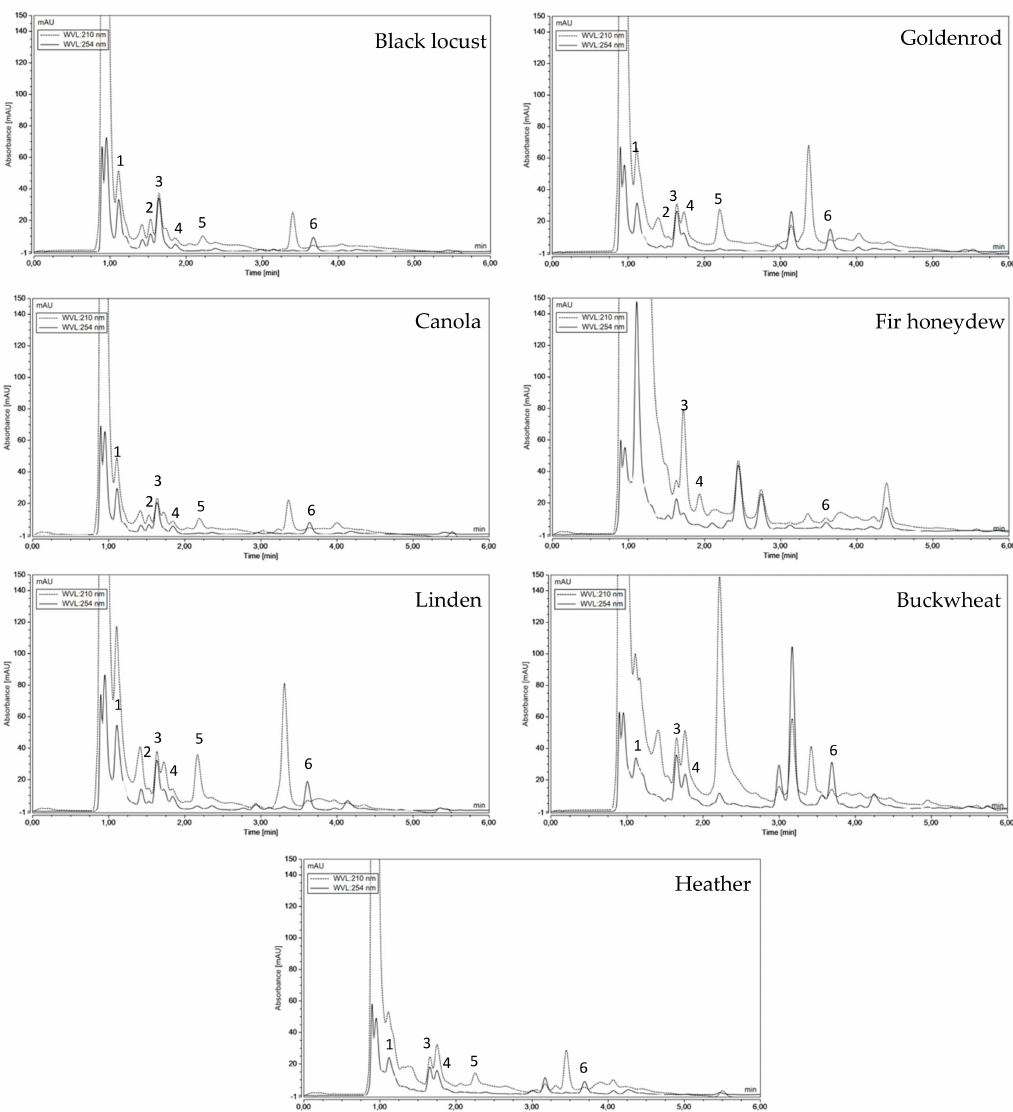
Figure 1. Representative UHPLC chromatographic profiles of di ff erent Polish unifloral honeys at λ = 210 nm and λ = 254